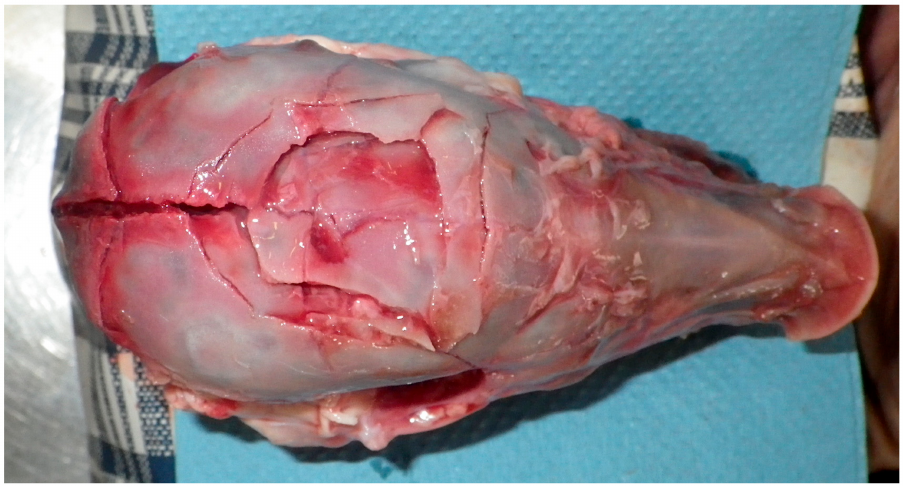
Figure 11. Fracture pattern at impact point. Skin, periosteum and haematoma removed.